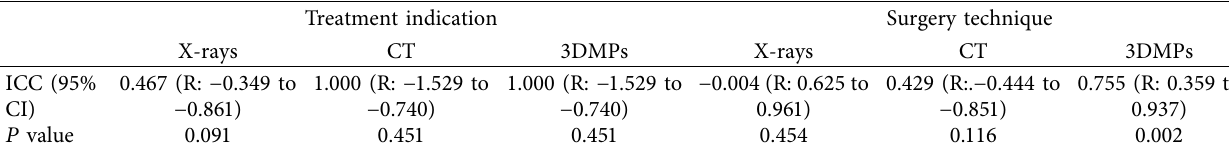
Table 3: Treatment and surgical technique’ interobserver reliability.